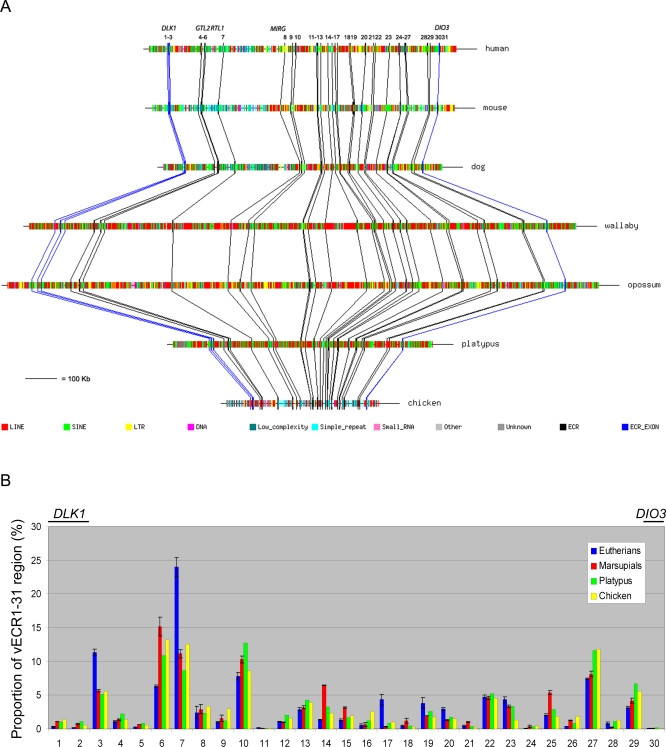
Comparative Analysis of Inter-ECR Zones in the DLK1-DIO3 Domain(A) ECRs identified in all seven species are shown as blue (Dlk1 and Dio3 exons) or black lines. The ECRs are linked to their orthologues in the neighbouring species in order to illustrate the repeat content and relative expansions/contraction within each sequence.(B) The length of each inter-ECR zones from vECR1 (DLK1 exon 3) to vECR31 (DIO3) as a proportion of the length of the domain in eutherians, marsupials, platypus, and chicken. Zone 1 = vECR1–vECR2, zone 2 = vECR2–vECR3, etc. Mean ± standard error for the three eutherians and the two marsupials are shown.